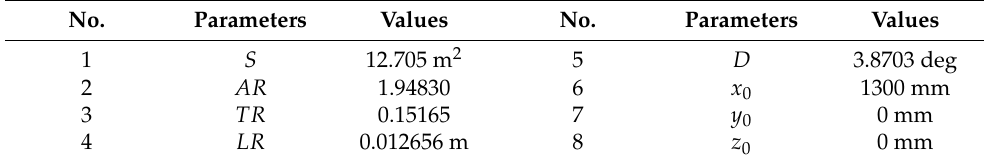
Table 1. Initial values of the independent